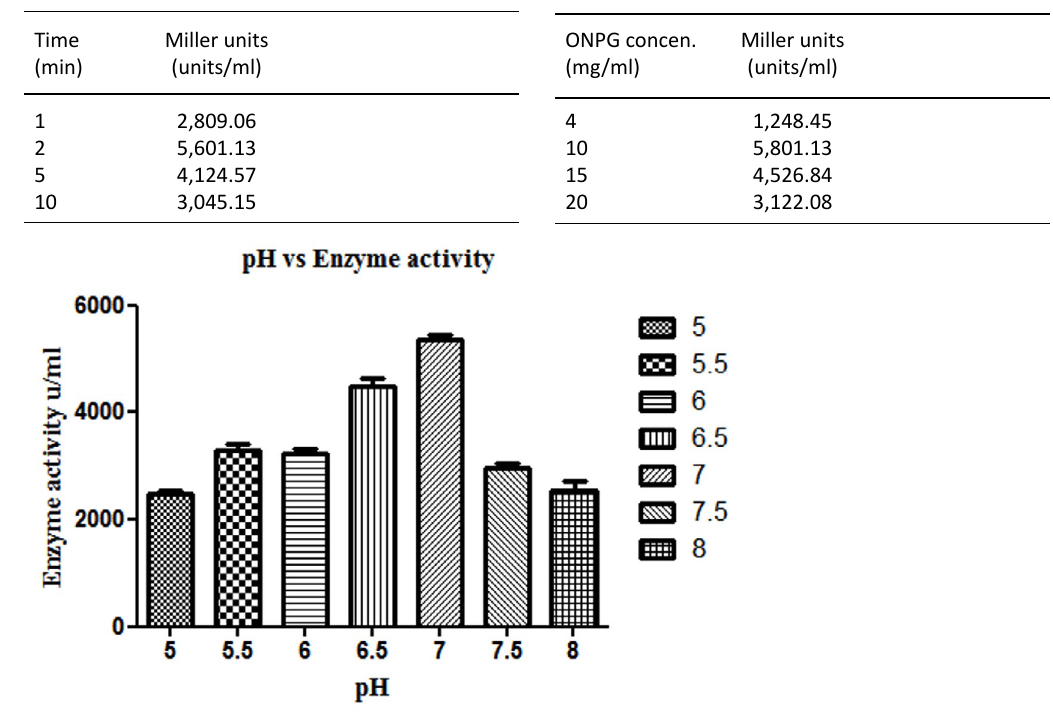
Table 3. Effect of reaction time on enzyme activity by L. fermentum